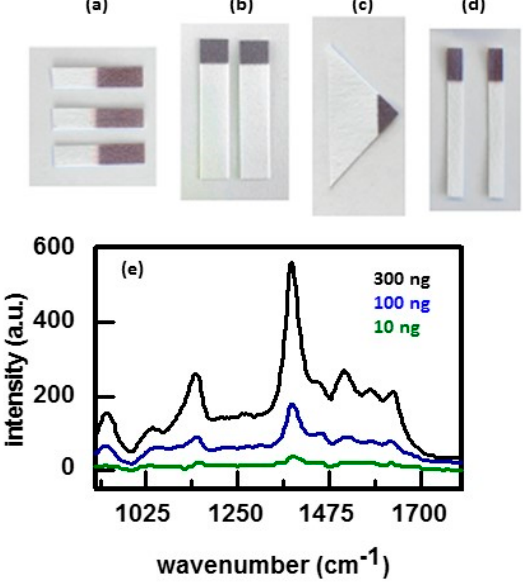
Figure 12. ( a – d ) Different geometries of P-SERS substrates where ( a ) is for use as a general SERS substrate; ( b ) is for use in lateral flow concentration experiments; ( c ) has a large wicking region for use as a dipstick, and ( d ) is for use as surface swabs; ( e ) SERS signal obtained by swabbing glass slides with varying amounts of thiram deposited on the respective surfaces. Amounts on the different surfaces are indicated. Reproduced with permission from Elsevier, 2013 [130].